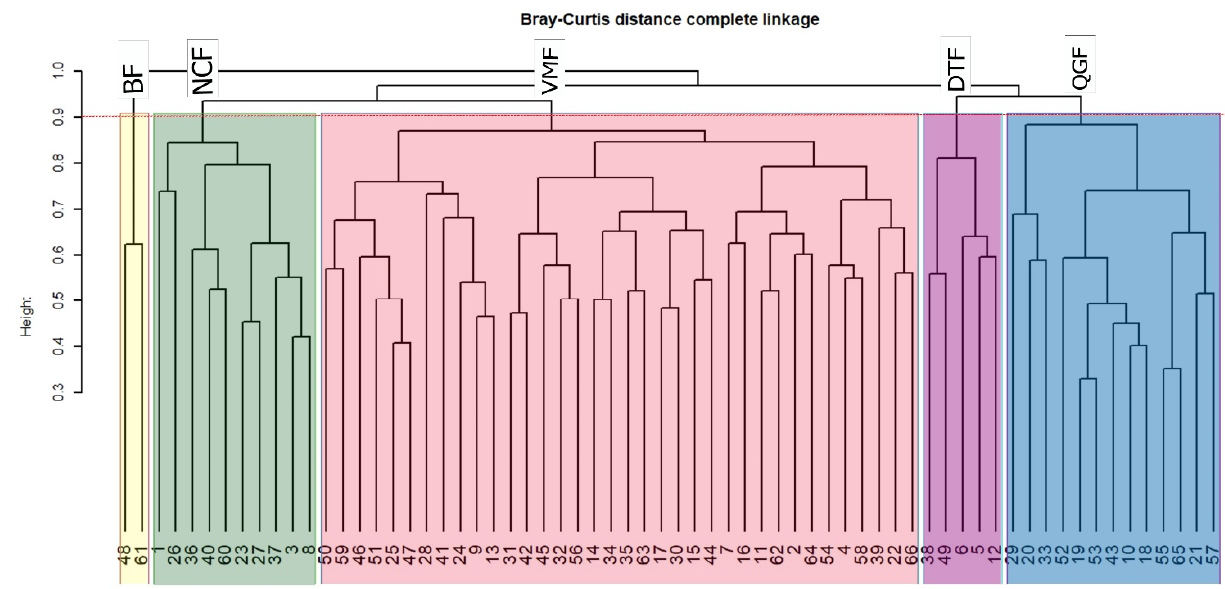
Figure 1. Dendrogram of all plots based on Bray–Curtis Distance complete linkage showing the five distinct forest communities of evergreen forest ecosystem in Htamanthi Wildlife Sanctuary in Myanmar. Forest communities: Bamboo forest (BF), Vatica maingayi forest (VMF), Quercus glauca forest (QGF), Nothaphoebe condensa forest (NCF), and Diospyros toposia forest (DTF).